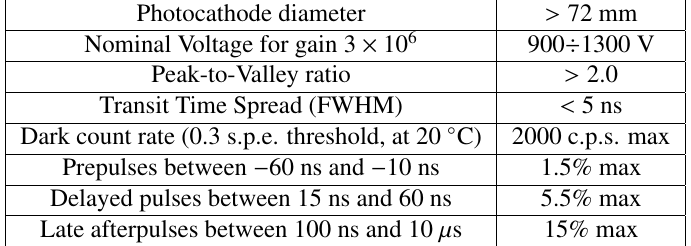
The dedicated studies on critical parameters done for the former PMT model were repli- cated with the new